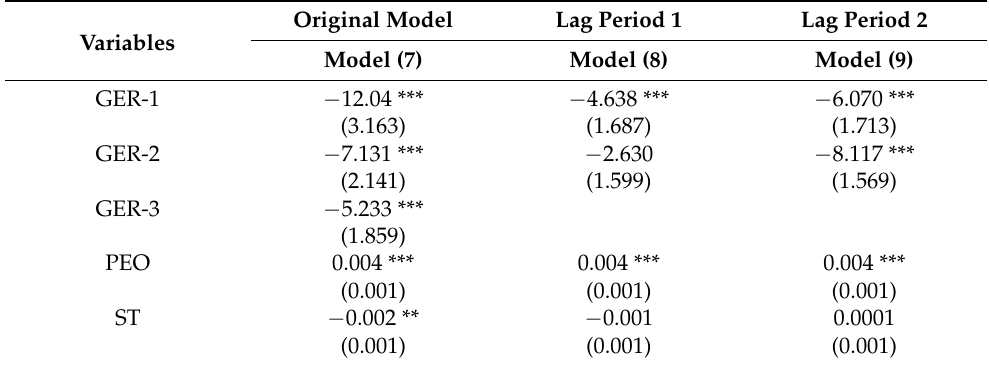
Table 6. Threshold regression results of environmental regulation in five urban